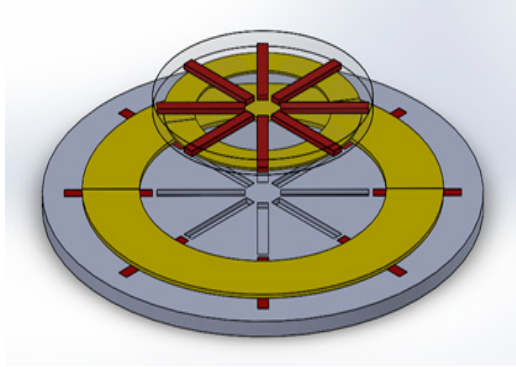
Figure 12. Two-coil system modeling.